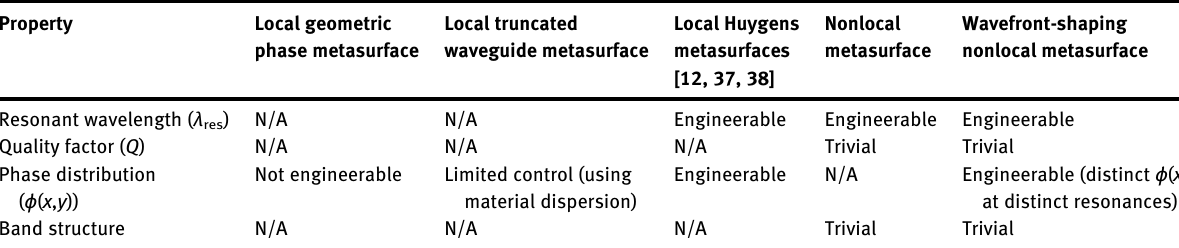
Table  : Comparison of properties tuned by refractive-index tuning. Property